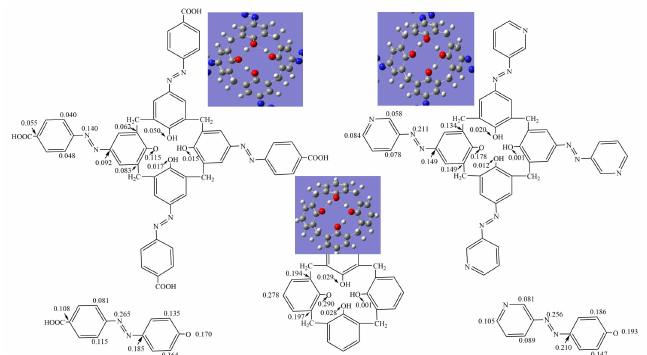
Figure 6. Spin density distribution in the phenoxyl radicals of azocalix[4]arene derivatives 1 and 2 , calix[4]arene, p -carboxyphenyl-azo-phenol and